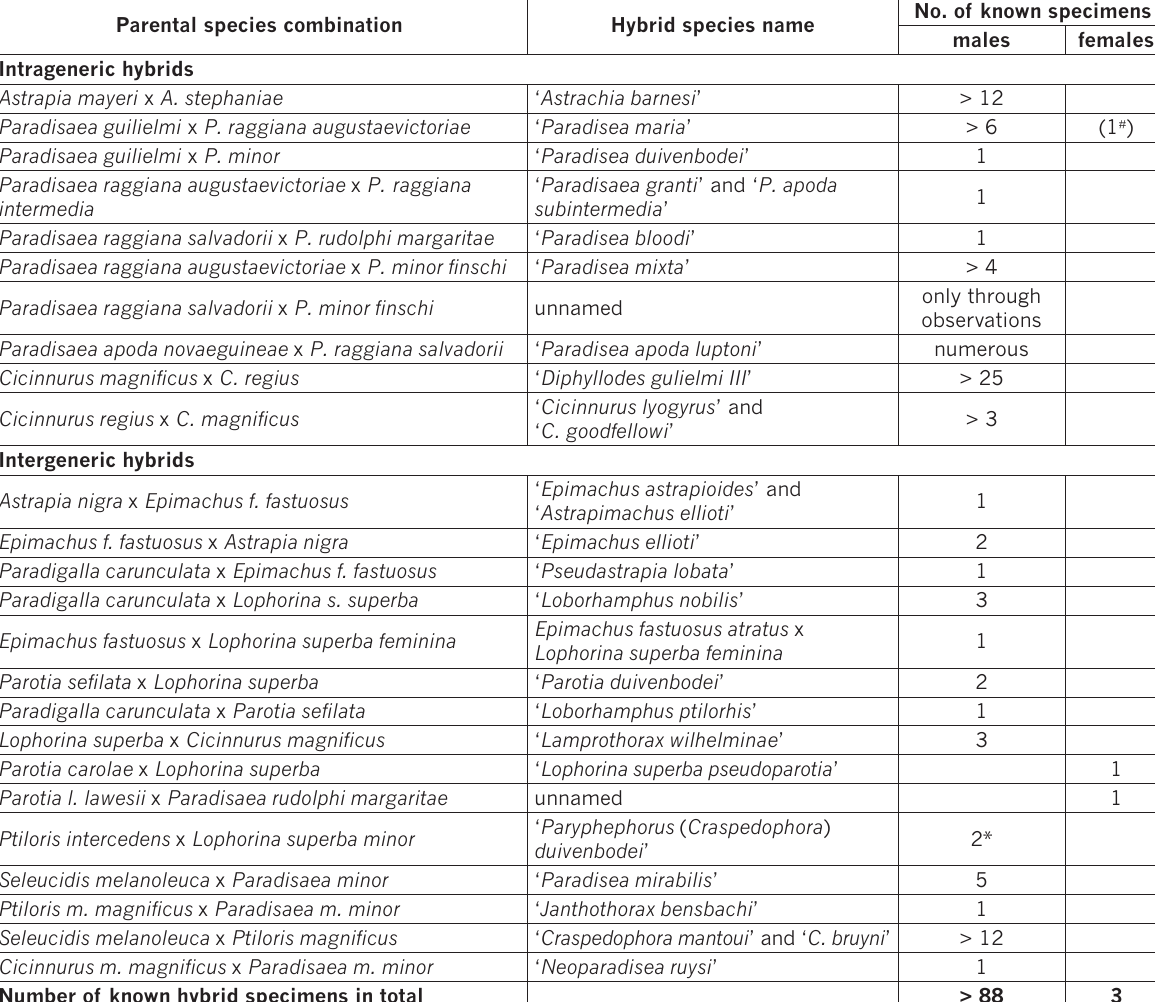
Table 1. Summary of known hybrid specimens of birds of paradise in international museum collections. In few cases, different hy - brid forms have been identified (and described) twice based on the same parental species combination, but apparently with varying influence of each species involved. *A third specimen, the holotype, was destroyed during WWII; # The hybrid status is uncertain. > Minimum number of specimens known. Data derived from Frith and Beehler